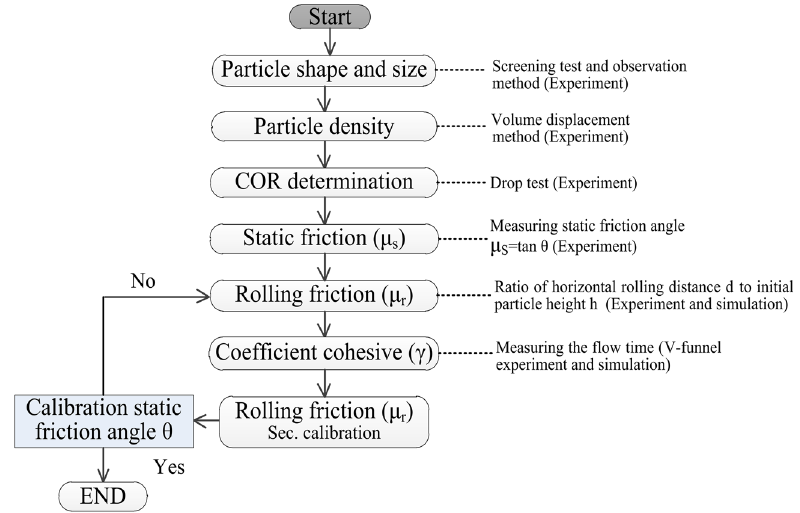
Figure 7: DEM parameter veri fi cation process of